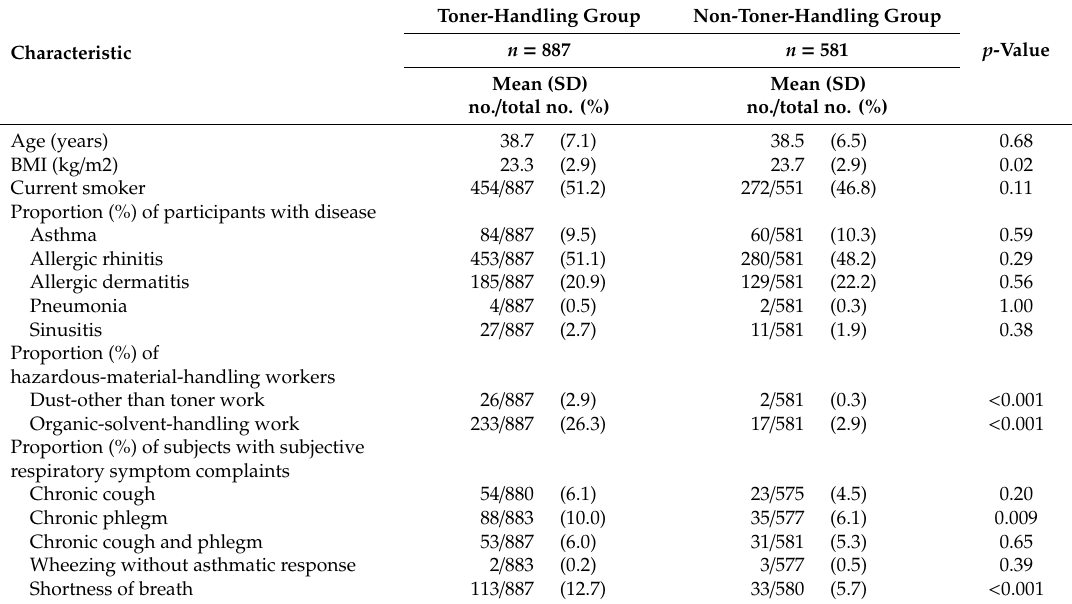
Table 1. Participants’ baseline